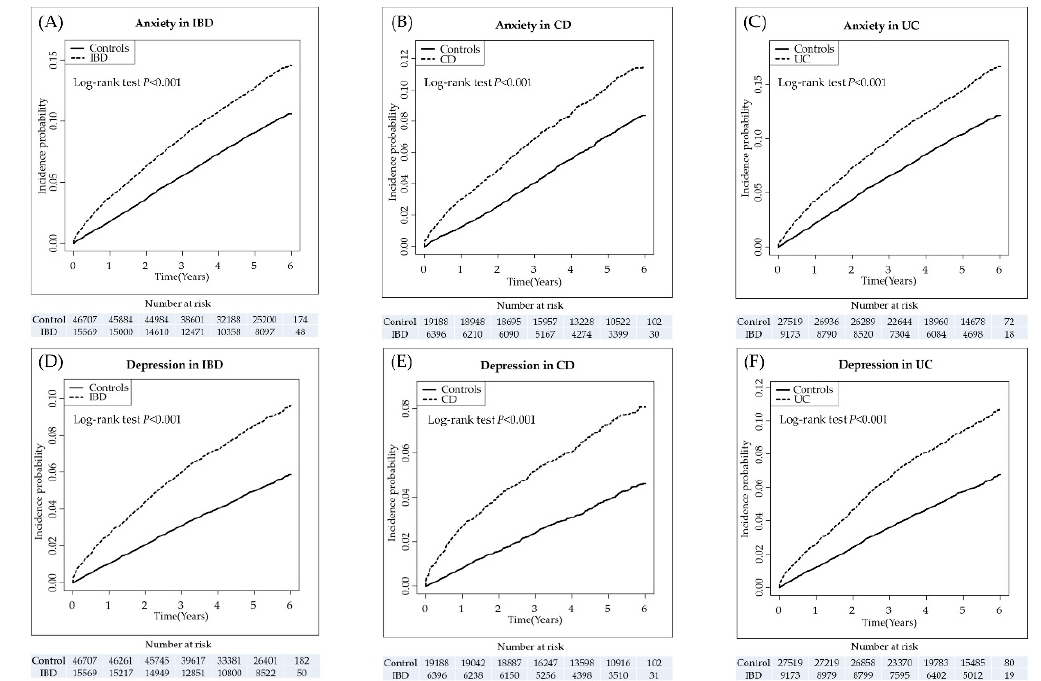
Figure 1. Cumulative incidence of anxiety and depression. Kaplan-Meier curves showed the incidence of anxiety ( A – C ) in patients with inflammatory bowel disease ( A ), Crohn’s disease ( B ), and ulcerative colitis ( C ), and depression (D-F) in those with inflammatory bowel disease ( D ), Crohn’s disease ( E ), and ulcerative colitis ( F ), compared to the general population, respectively. CD, Crohn’s disease; IBD, inflammatory bowel disease; UC, ulcerative colitis.